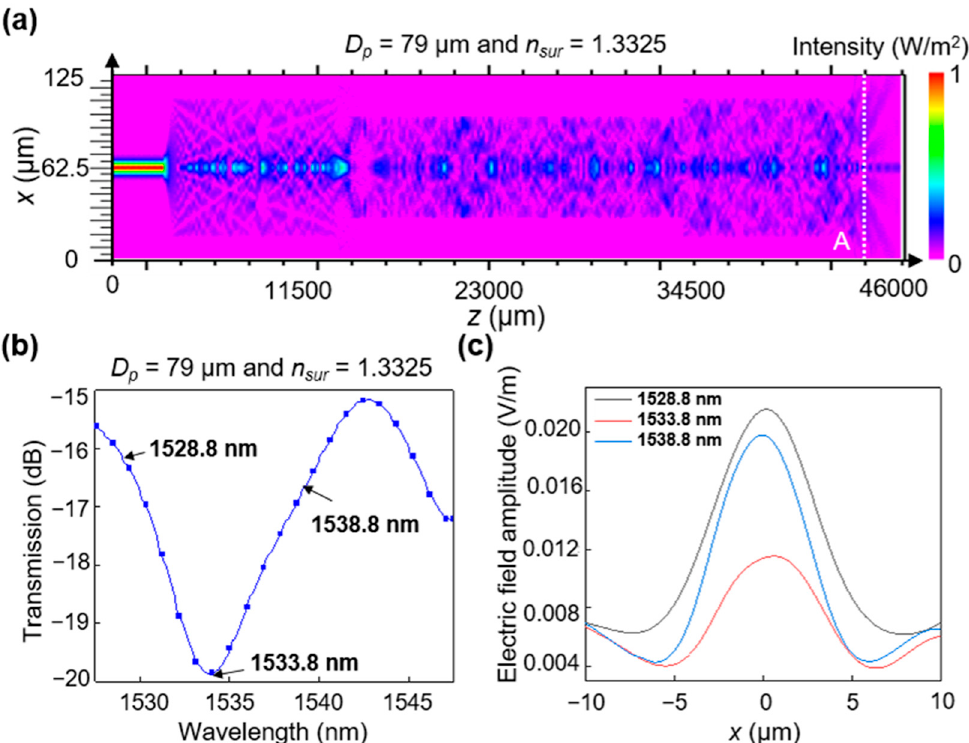
Figure 2. Calculated transmission characteristics of the sensor: ( a ) MMI behavior of the optical field prop ‐ agating along the dual ‐ side polished SMS fiber surrounded by the medium ( n sur = 1.3325) at a wavelength of 1533.8 nm. ( b ) Calculated transmission spectrum of the proposed device surrounded by the medium ( n sur = 1.3325) with D p = 79 μ m. ( c ) Calculated optical electric field amplitude at the cross ‐ section corre ‐ sponding to position A ( z = 43,000 μ m) in ( a ).